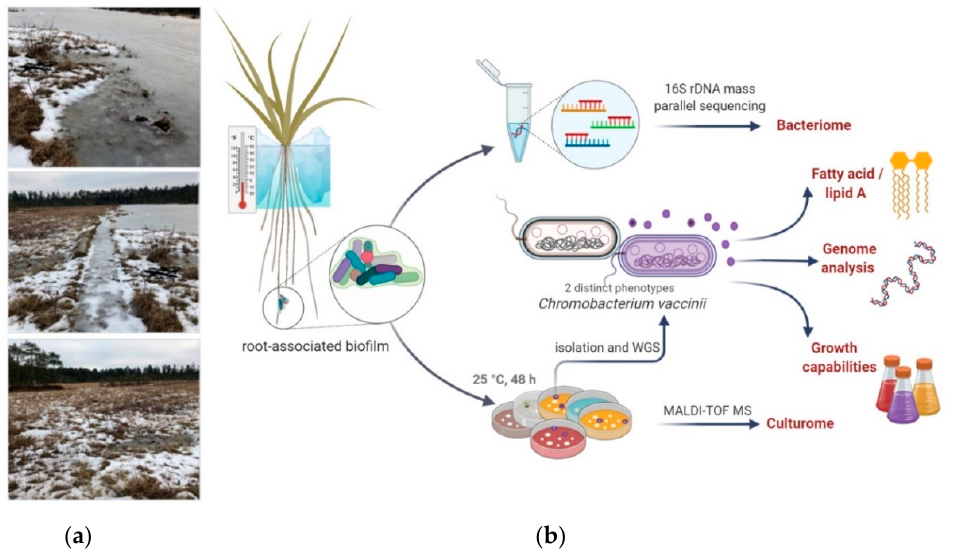
Figure 1. General description of the study design. ( a ) Photography of the location at the day of sampling. ( b ) Sample processing workflow. Picture was created with BioRender.com.